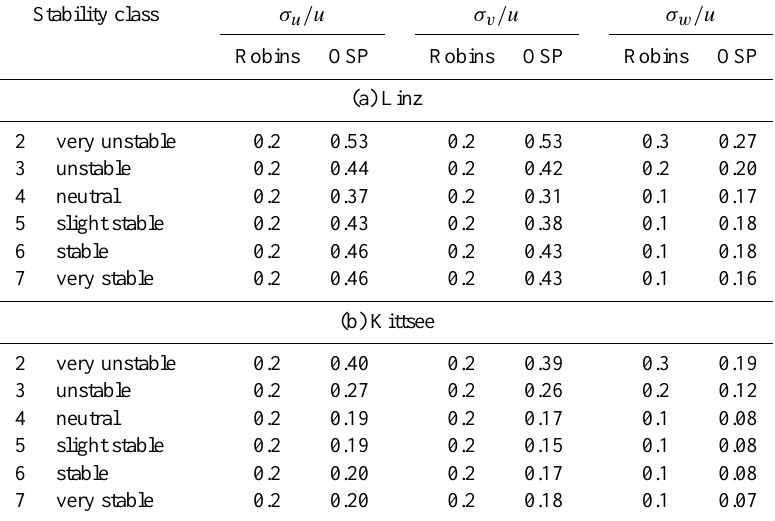
Table 1. Ratios of the standard deviations of the three wind components σ u , σ v and σ w to the horizontal wind velocity u depending on the stability of the atmosphere. Values proposed by Robins (1979) are compared to site-specific ratios derived from 3-D ultrasonic anemometer measurements